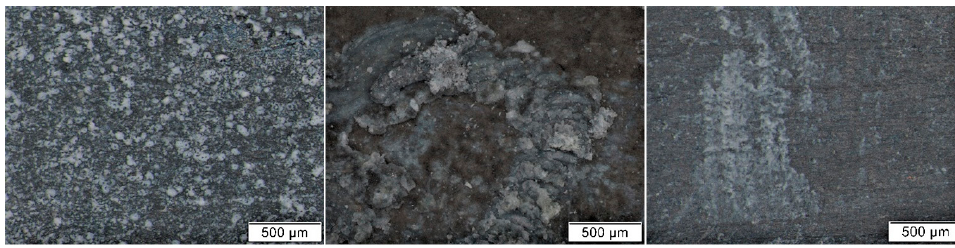
Figure 9. Total color difference of lead corrosion coupons after 1–30 months of exposure.